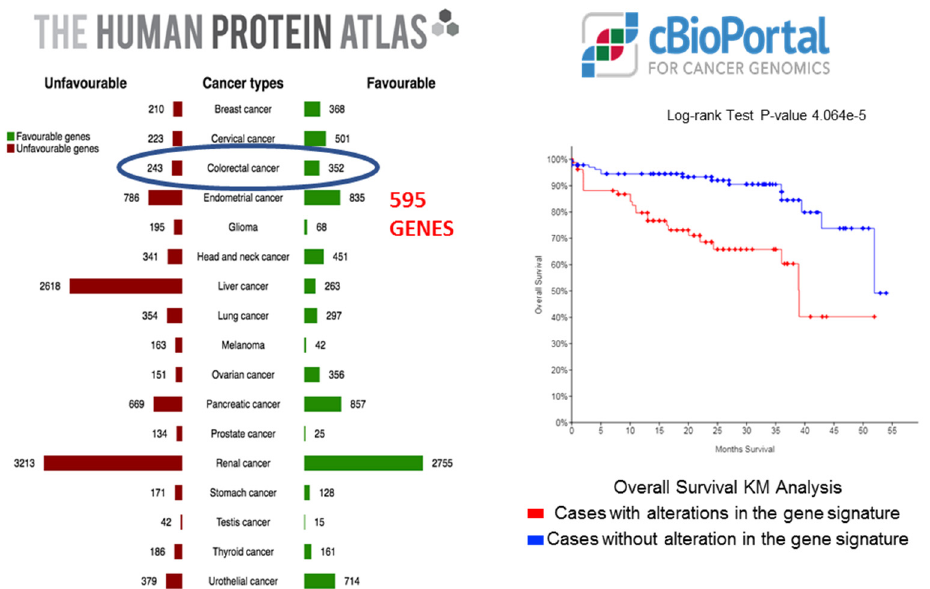
Figure 8. The 595 candidate gene-set was extracted from The Protein Atlas. The gene expression of 7 top-most altered genes ( PI4K2B, PBXIP1, CHEK1, DLAT, FAM50A, KDM4B, DPP7/2 ) significantly differentiated patients on the basis of overall survival in cBioportal, with perturbations in 37% of CRC patients ( n = 222).